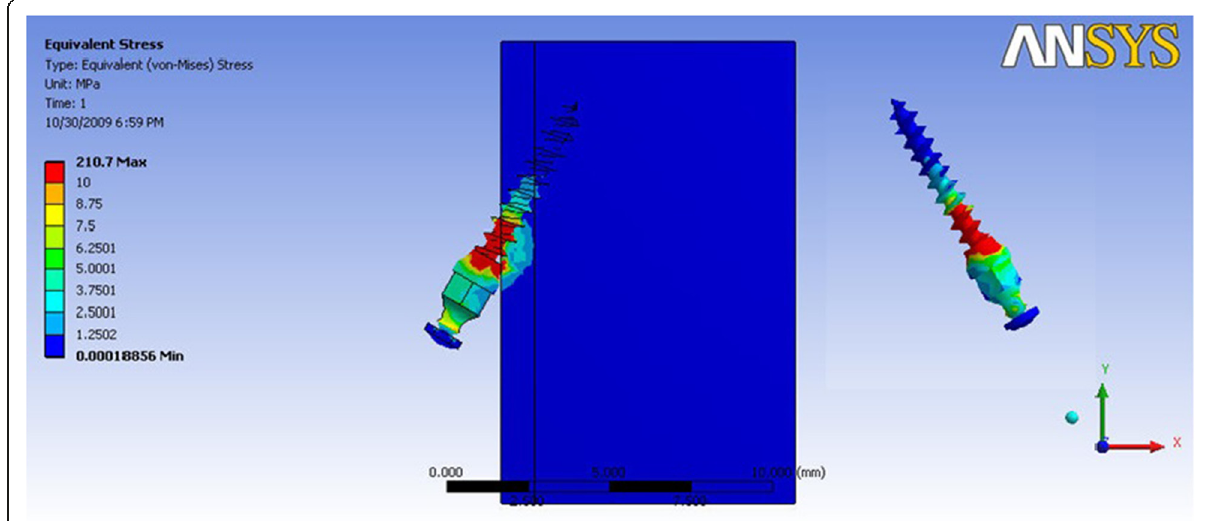
Fig. 6 von Mises stress distribution for mini-implant group 3a — anterior intrusion and retraction: von Mises stress distribution seen at the bone-implant interface and in the mini-implant alone. Maximum stress seen in the mini-implant was at 210.22 MPa